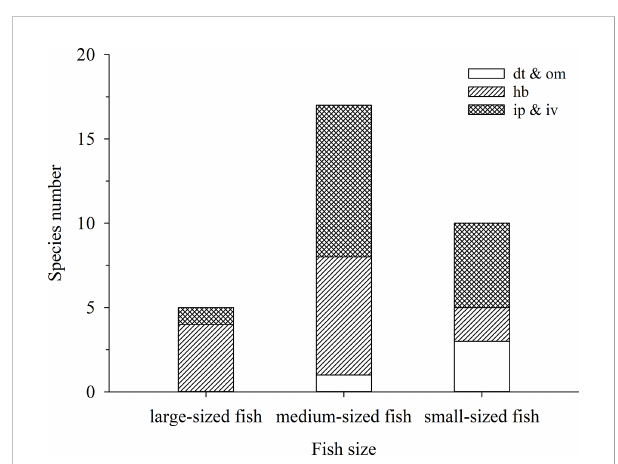
FIGURE 7 Composition of size and trophic group of 32 fi sh appearing in 1998 — 1999 but not in 2012 — 2018 in the lagoon of Meiji Reef. The dt, hb, ip, iv, and om mean detritivores, herbivores, piscivores, invertebrate feeders, and omnivores respectively.